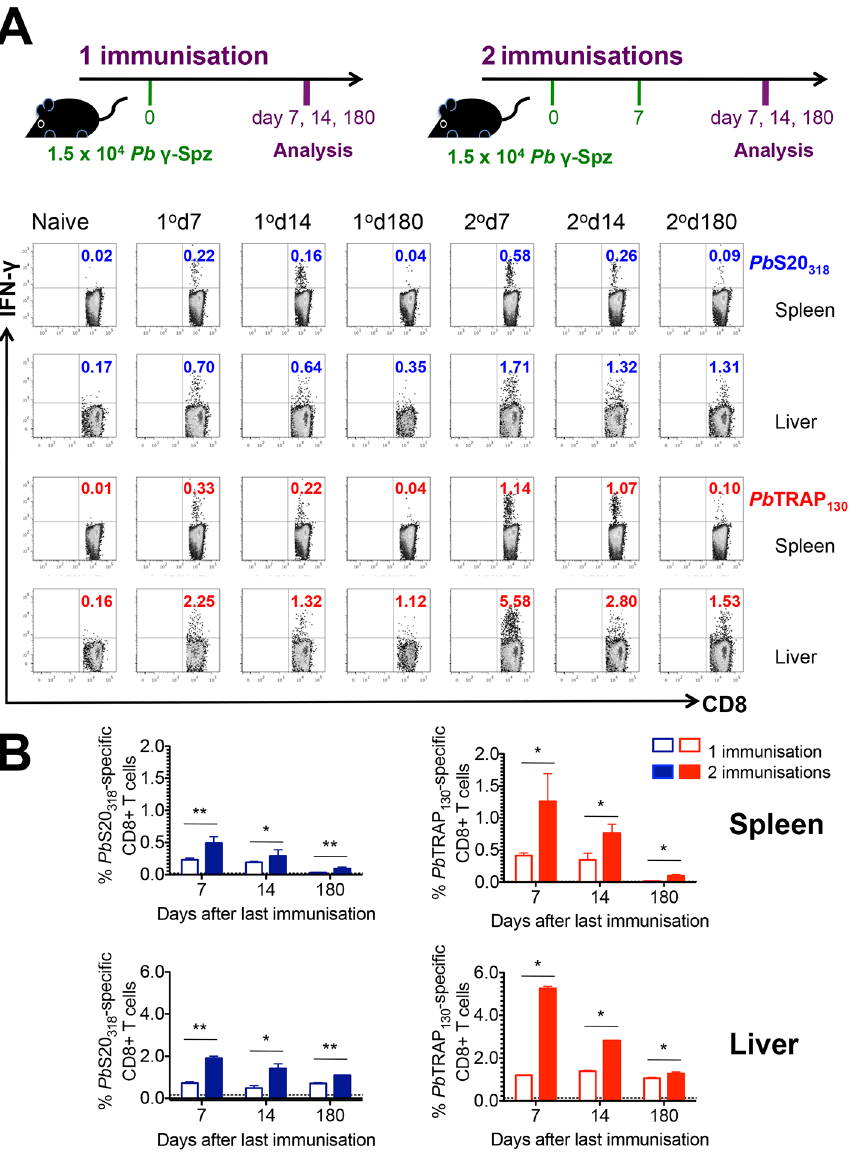
Figure 2. Kinetics of Pb S20 318 and Pb TRAP 130 -specific CD8 + T cell responses following immunisation with Pb c -Spz. ( A ) B6 mice were immunised either once or twice with Pb c -Spz as shown in the schematic diagram. On days 7, 14 and 180 after the last immunisation, Pb S20 318 and Pb TRAP 130 -specific CD8 + T cell responses were quantified in the spleens and the livers by peptide stimulation followed by ICS. Representative flow cytometry plots showing IFN- c -secretion by CD8 + T cells in the spleens and the livers of Pb c -Spz-immunised mice. ( B ) Data in (A) presented as bar graphs: white squares=1 u immunisation, black squares=2 u immunisation (blue for Pb S20 318 and red for Pb TRAP 130 ), differences between 1 u vs 2 u immunisations: **p , 0.01 and *p , 0.05, Mann-Whitney test. Dotted lines represent baseline responses based on peptide stimulation of spleens from naı¨ve mice. Experiments were performed at least 5 times with 3–5 mice per group. Frequencies of epitope-specific CD8 + T cells were also compared among the different time points and were found to be statistically different (p , 0.05) using the Kruskal Wallis test.